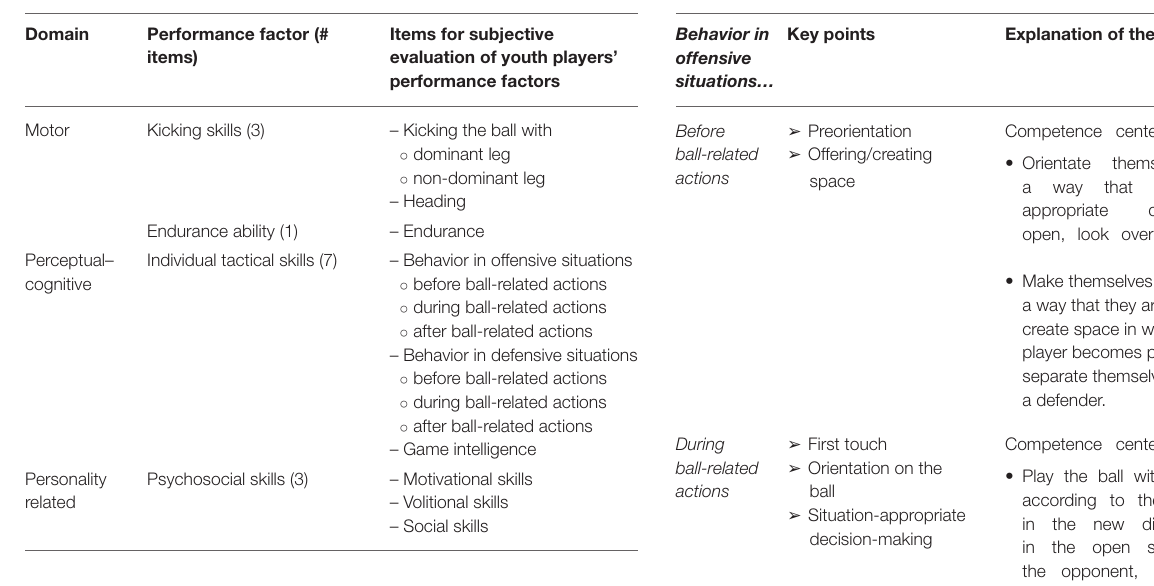
TABLE 2 | Key points and their explanations for rating players’ individual tactical skills in offensive situations (before, during, and after ball-related